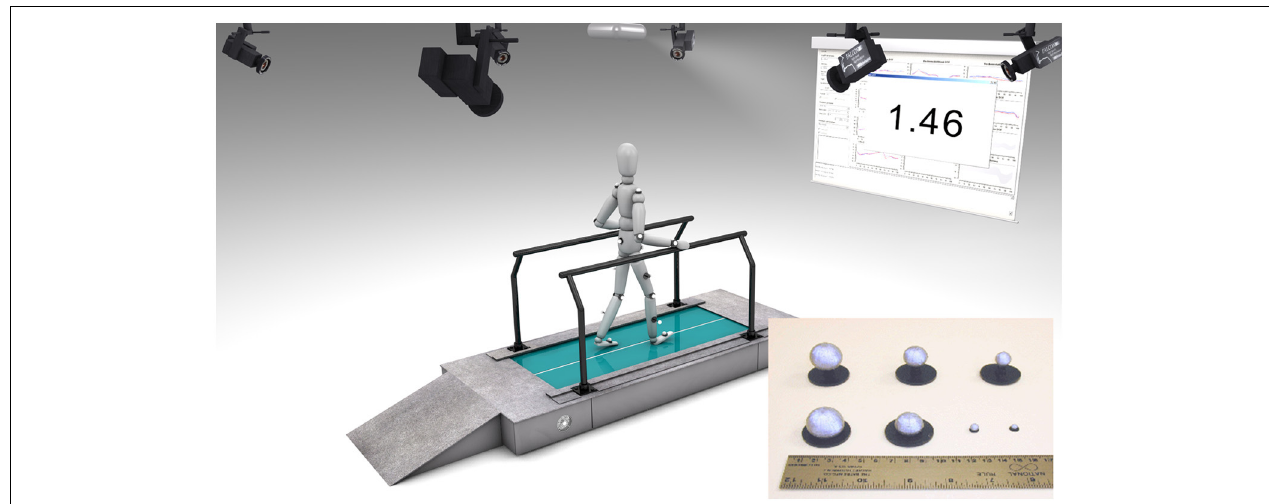
FIGURE 1 | Components of the feedback system used in this study. Infrared motion capture system using reflective markers associated with a customized treadmill. Knee joint angles are